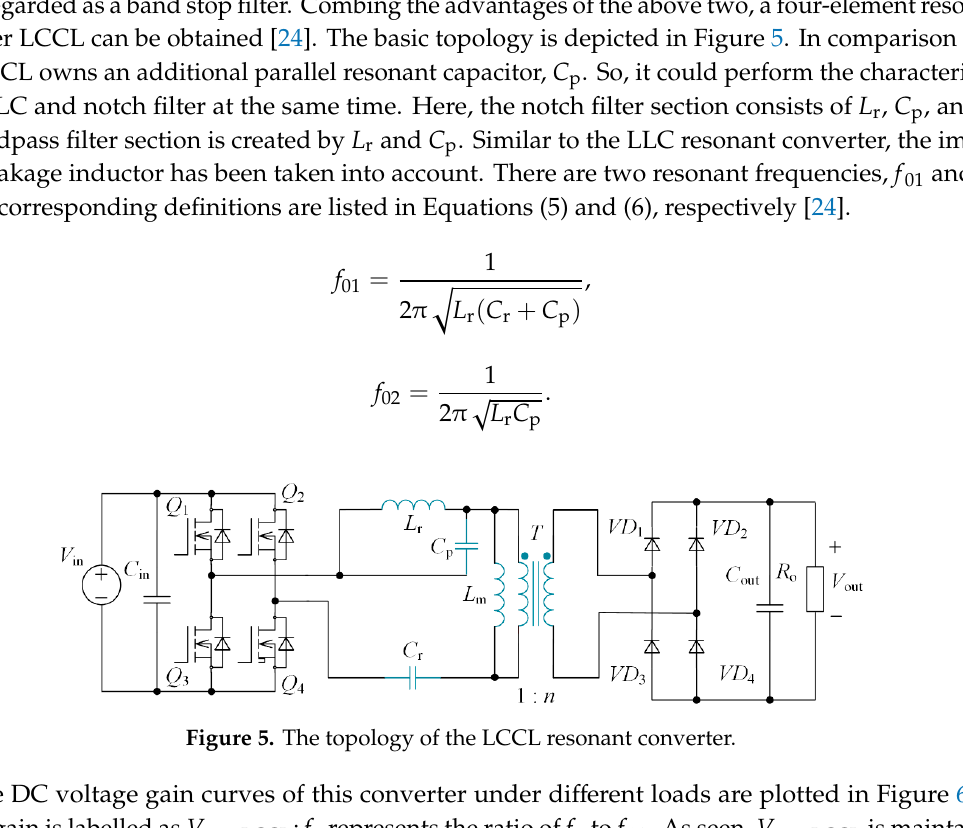
Figure 5. The topology of the LCCL resonant converter.